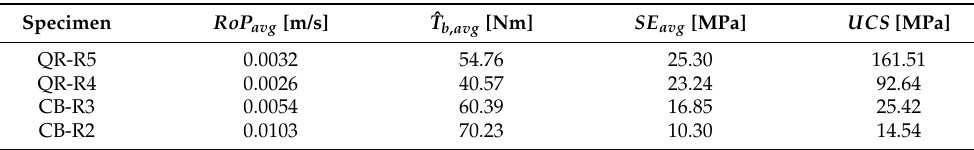
Table 6. Experimental results of average RoP , average steady ˆ T b , average steady SE and UCS for 4 testing